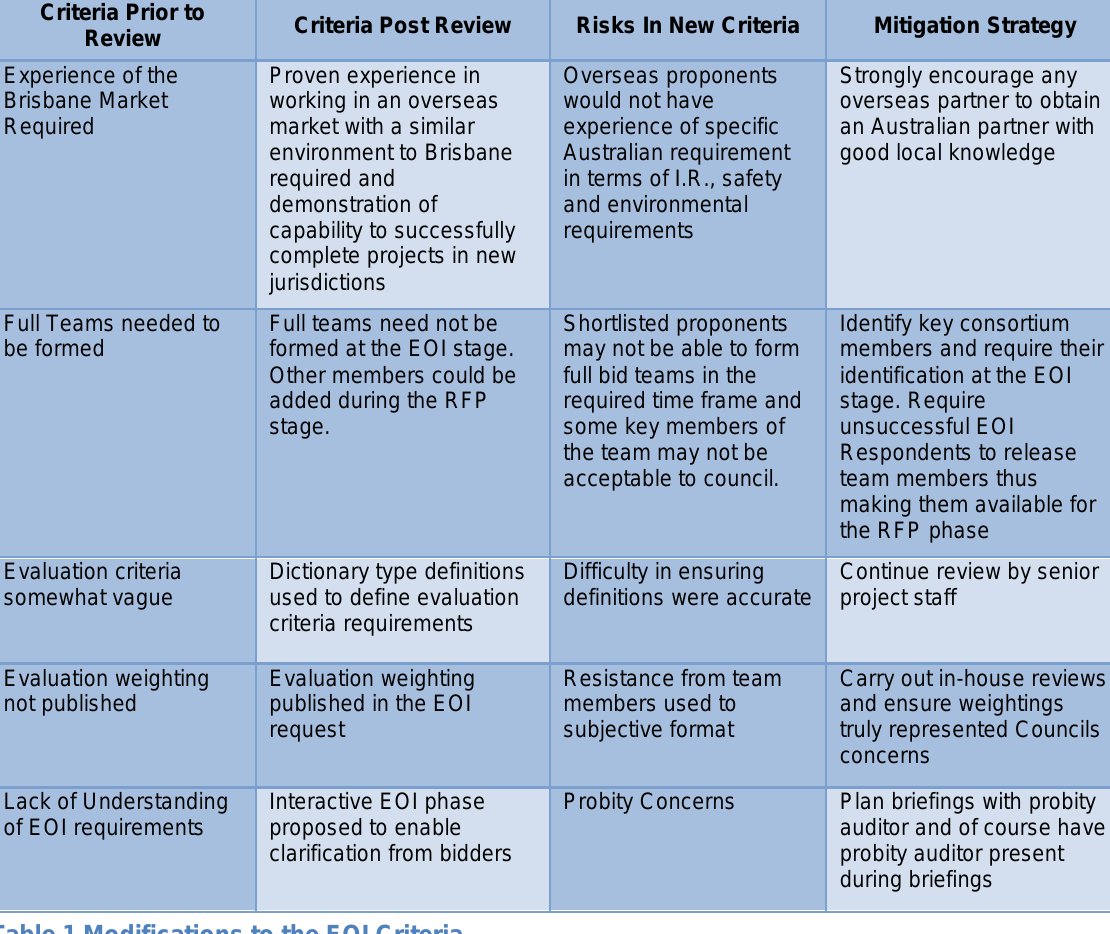
Table 1 Modifications to the EOI